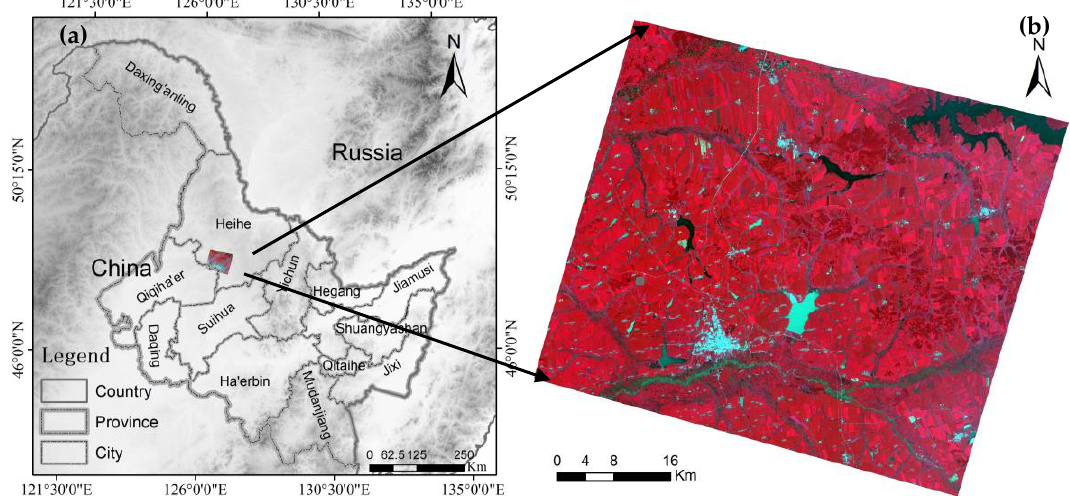
Figure 1. Location of study area ( a ) and the false color Landsat-8 image of study area (near infrared (NIR), red, green as R, G, B) ( b ).